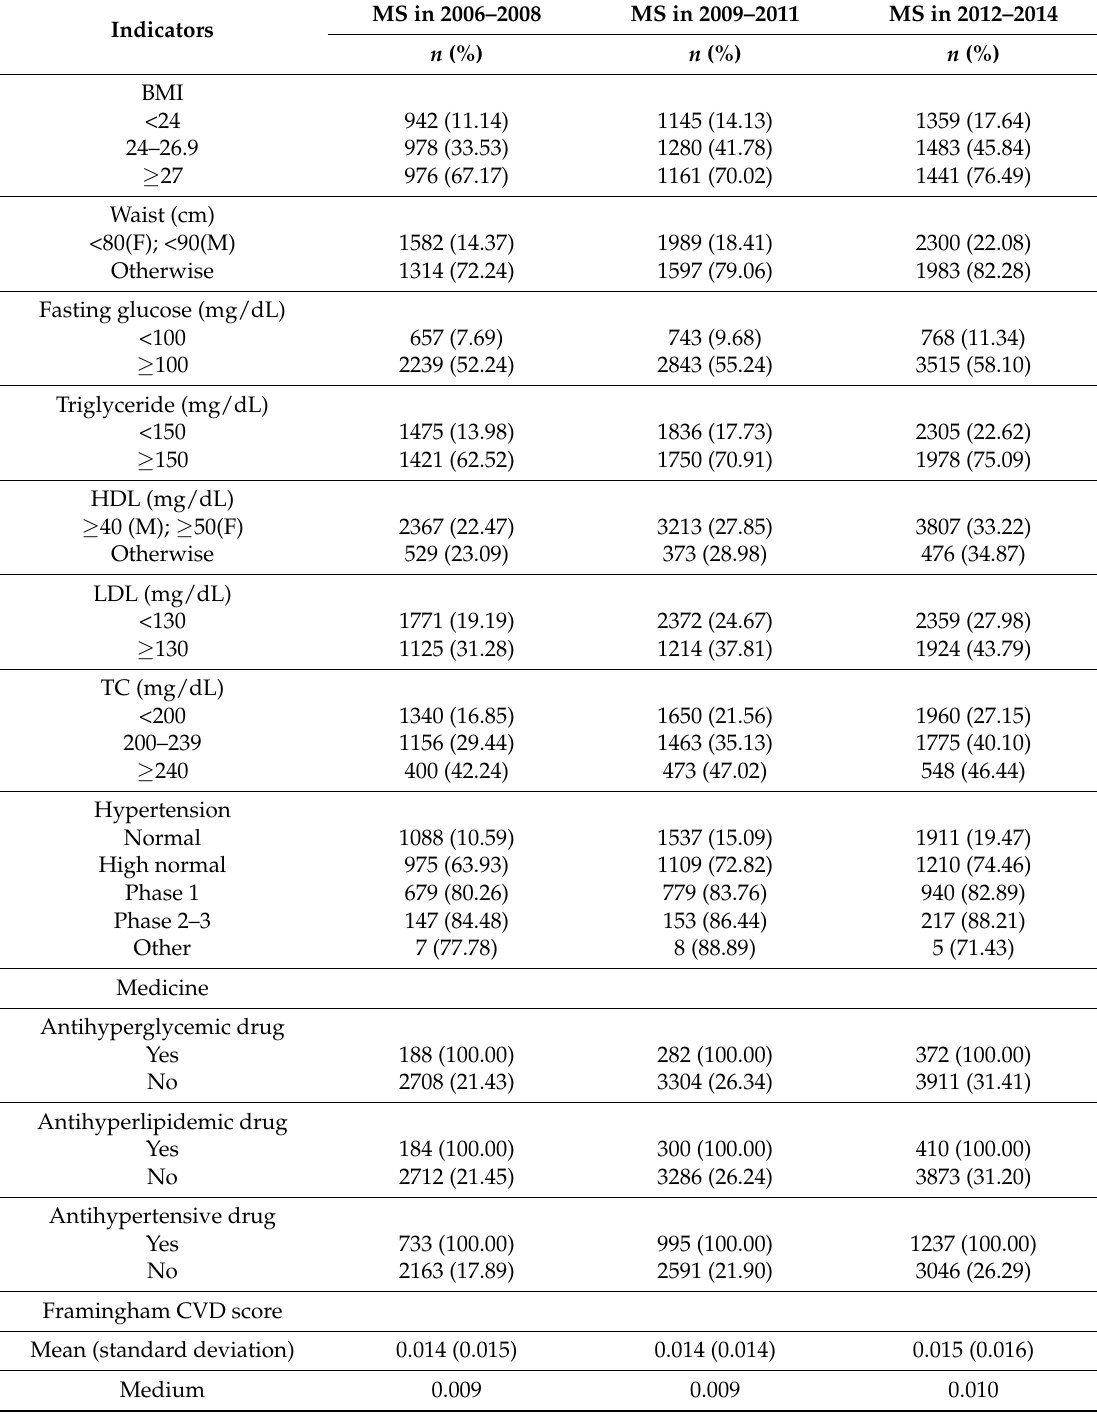
Table 2. Risk indicators of metabolic syndrome and cardiovascular diseases over the three study